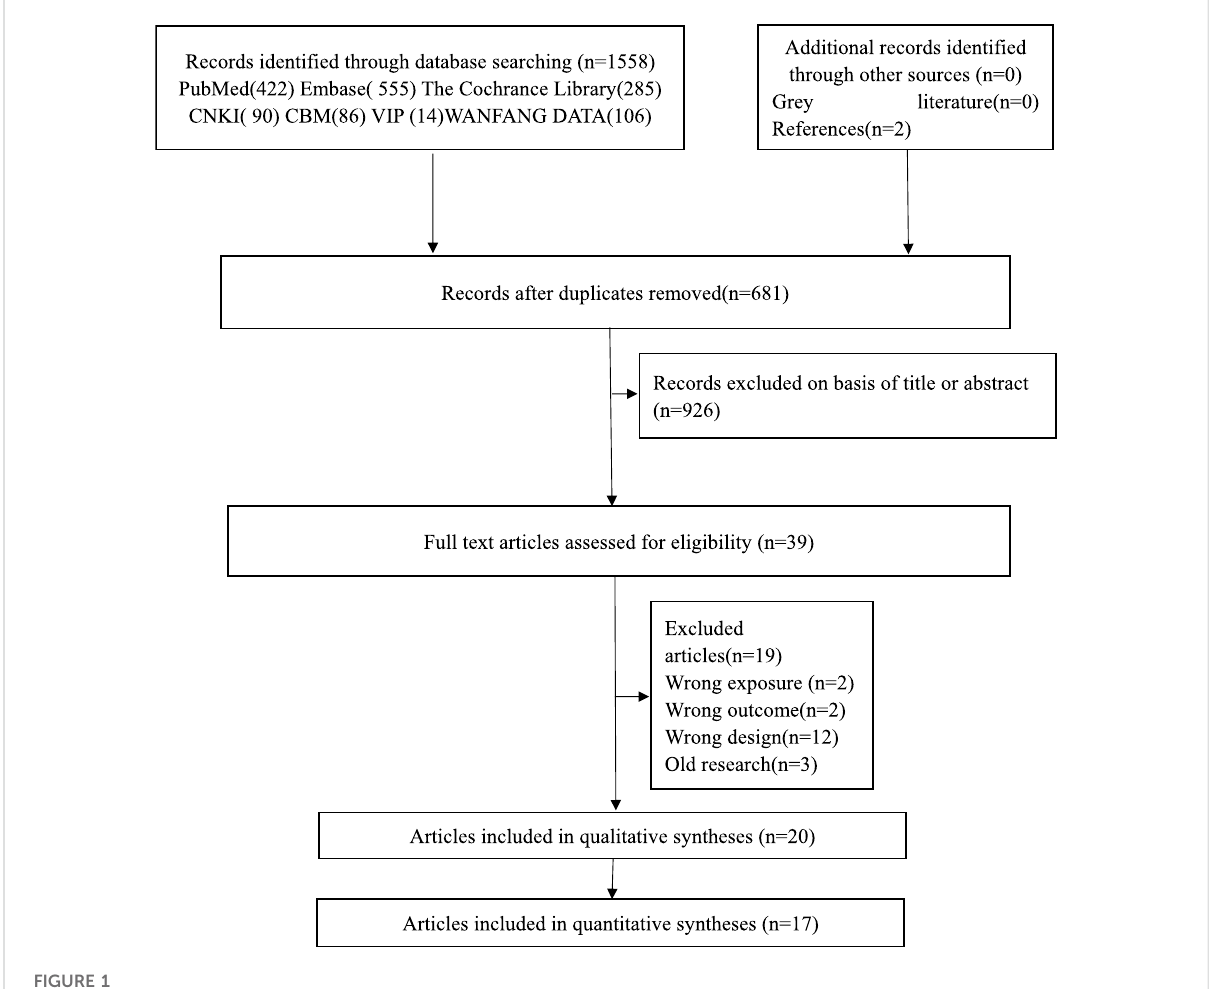
FIGURE 1 PRISMA fl ow